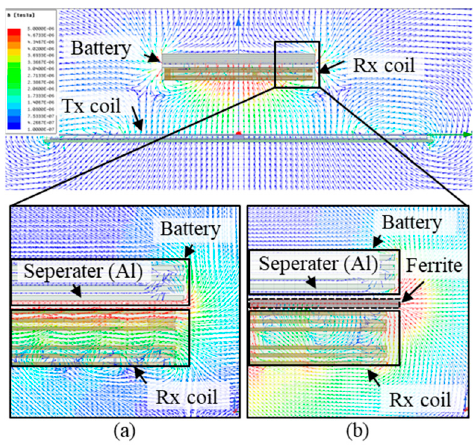
Figure 9. Distribution of magnetic field vectors. The inserted magnetic material detours the incident magnetic flux. ( a ) Model without magnetic material; ( b ) model with magnetic material (ferrite).